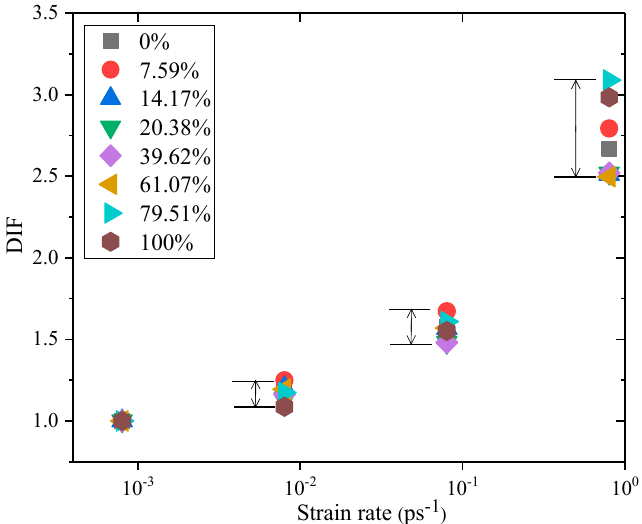
Figure 4. Relationship between dynamic increase factor of C–S–H and strain rate at different degree of saturation . of